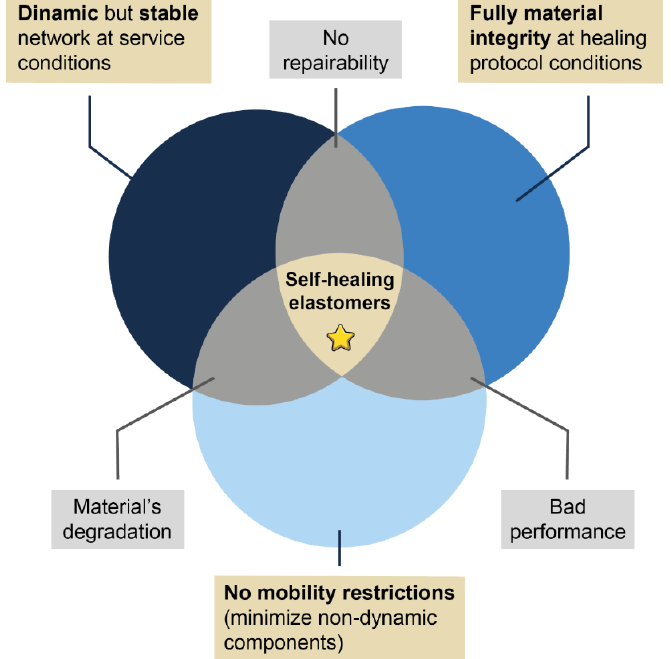
Figure 12. Venn diagram illustrating optimal healing conditions.